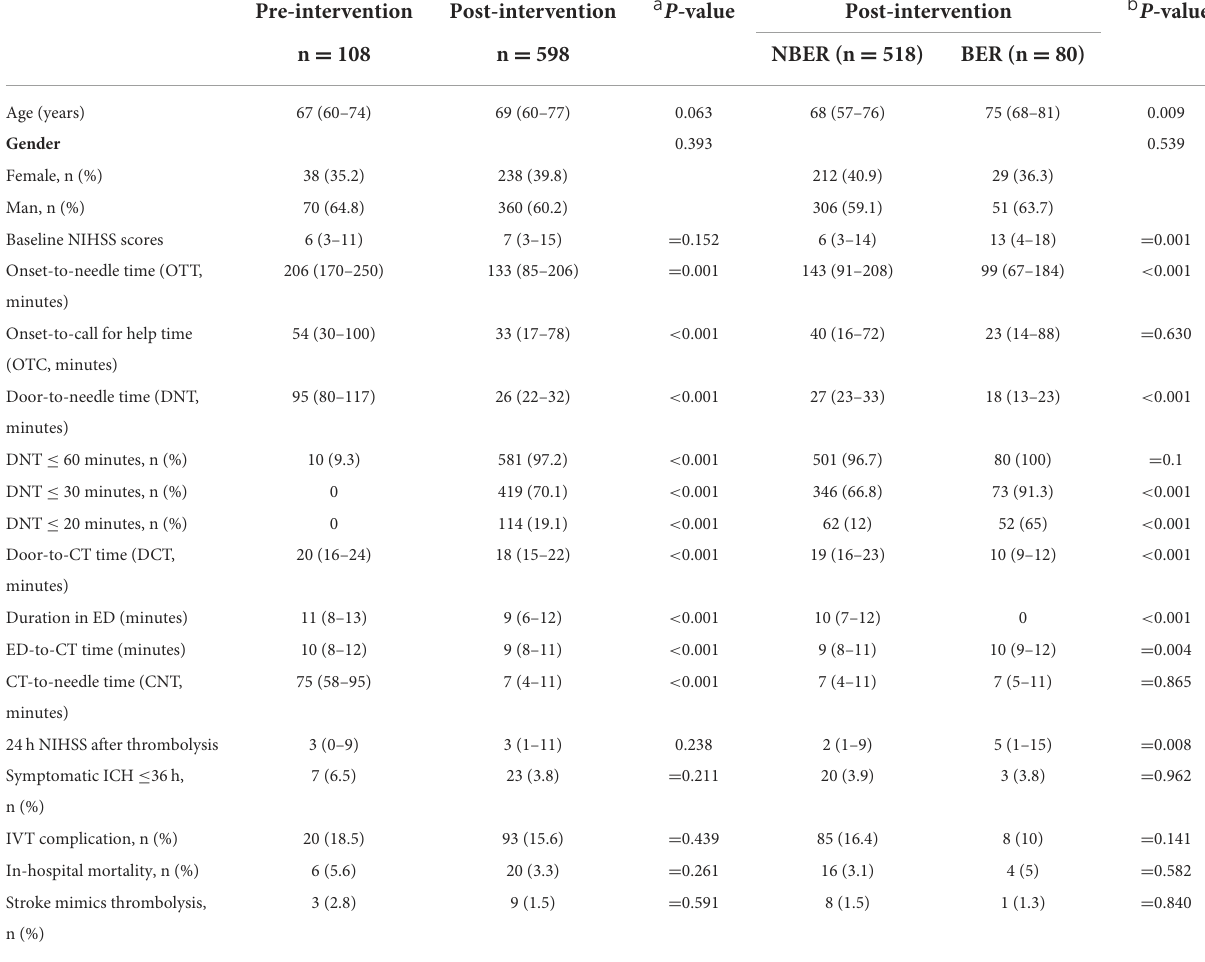
TABLE 2 Baseline characteristics, time intervals, outcome and safety measurements of patients in pre-intervention, post-intervention, NBER and BER groups. Pre-intervention Post-intervention a P -value